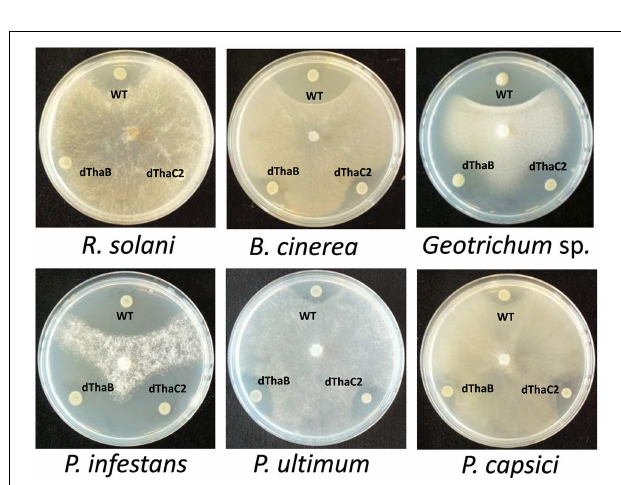
information is scattered over contigs and needs to be confirmed. Dotted lines indicate (expected) sequence conservation. Amino acids are indicated in their standard three-letter annotation. Non-standard amino acids were abbreviated as follows: Hse, homoserine; Ilx, isoleucine or leucine; Dab, 2,4-diaminobutanoic acid; Dhb, 2,3-dehydro- 2-aminobutanoic acid; Dhp, dehydro-2-aminopropanoic acid (dehydroalanine). The asterisk in the thana/cormycin structure indicates chlorination of this amino acid.